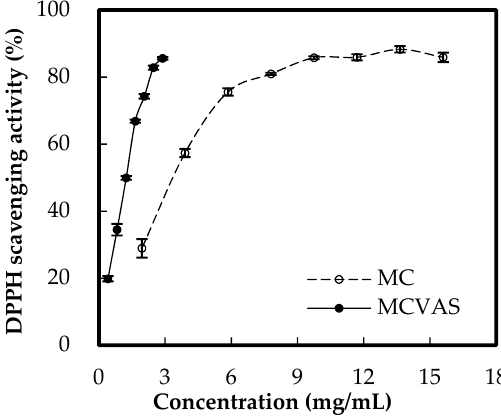
Figure 3. Effects of sample concentration on 1,1-diphenyl-2-picrylhydrazyl scavenging activity. Figure 3. E ff ects of sample concentration on 1,1-diphenyl-2-picrylhydrazyl scavenging